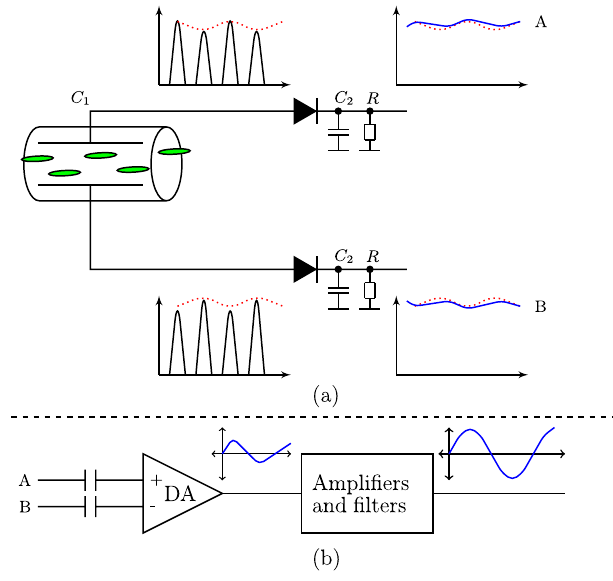
FIG. 7. BBQ: Baseband Q measurement system. Diode detec- tors (a) and signal chain (b).